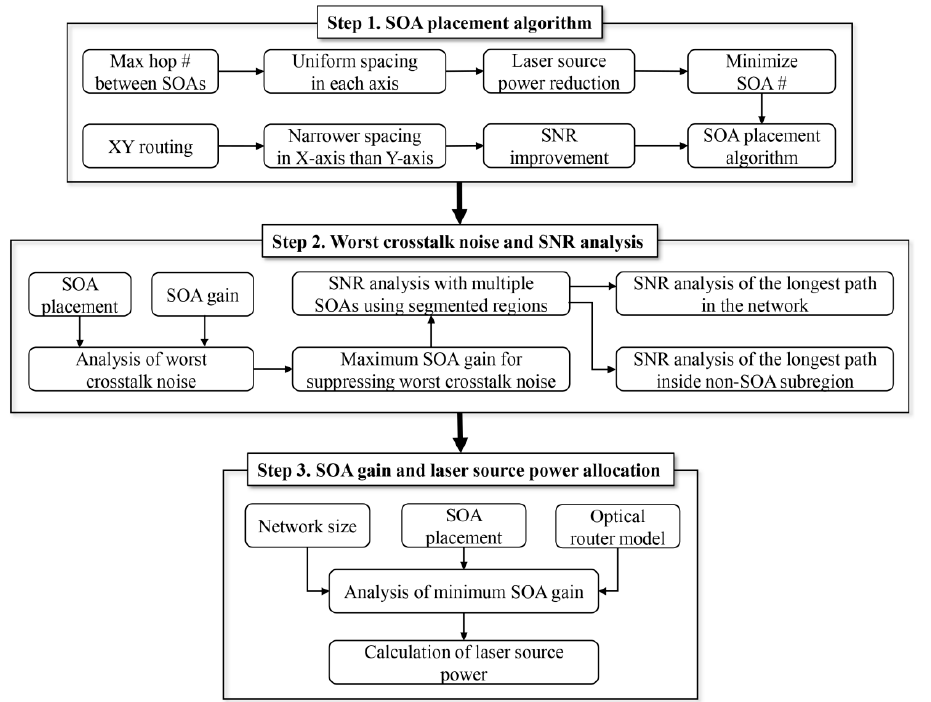
Figure 4. Overall flow of the proposed design methodology.